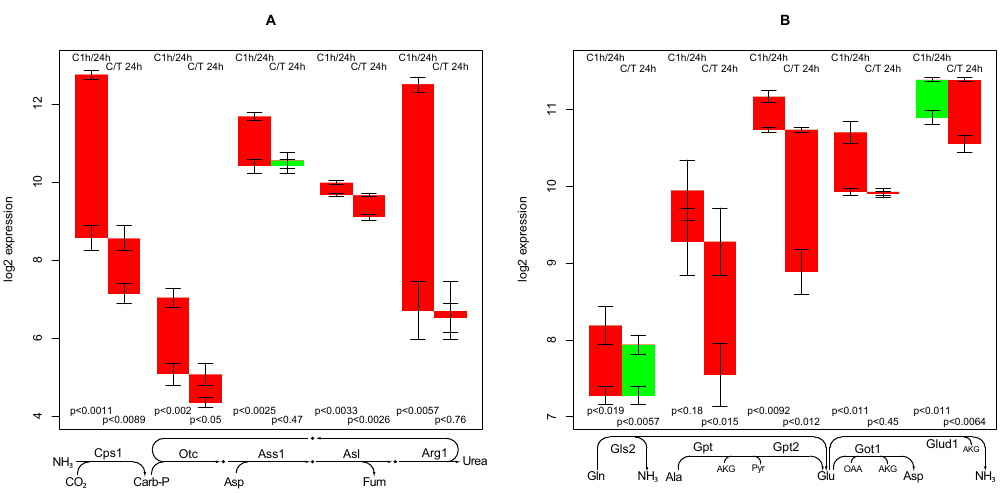
Figure 4. Regulation of genes involved in urea synthesis. Panel (A) shows genes essential for urea synthesis, whereas panel (B) shows genes used for the supply of